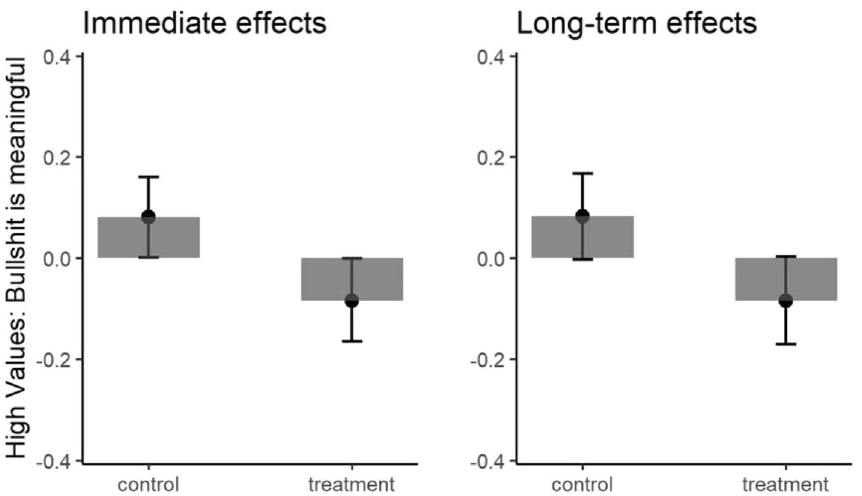
Figure 7. Bullshit receptivity immediately after the intervention (left panel) and 4 weeks later (right panel). Error bars represent standard errors. The y-axis represents standardized scores in terms of bullshit receptivity ratings controlled for pre-intervention bullshit receptivity ratings. Higher scores indicate beliefs in bullshit are meaningful such as “interdependence is rooted in ephemeral